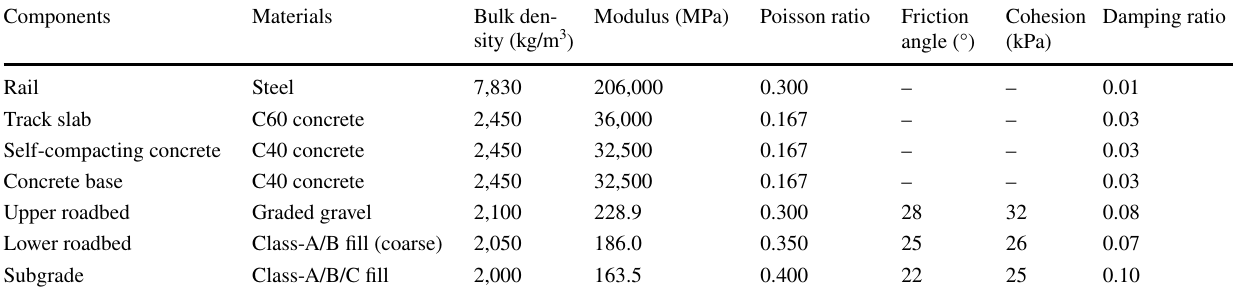
Table 1 Material properties of the FE model [17, 18]